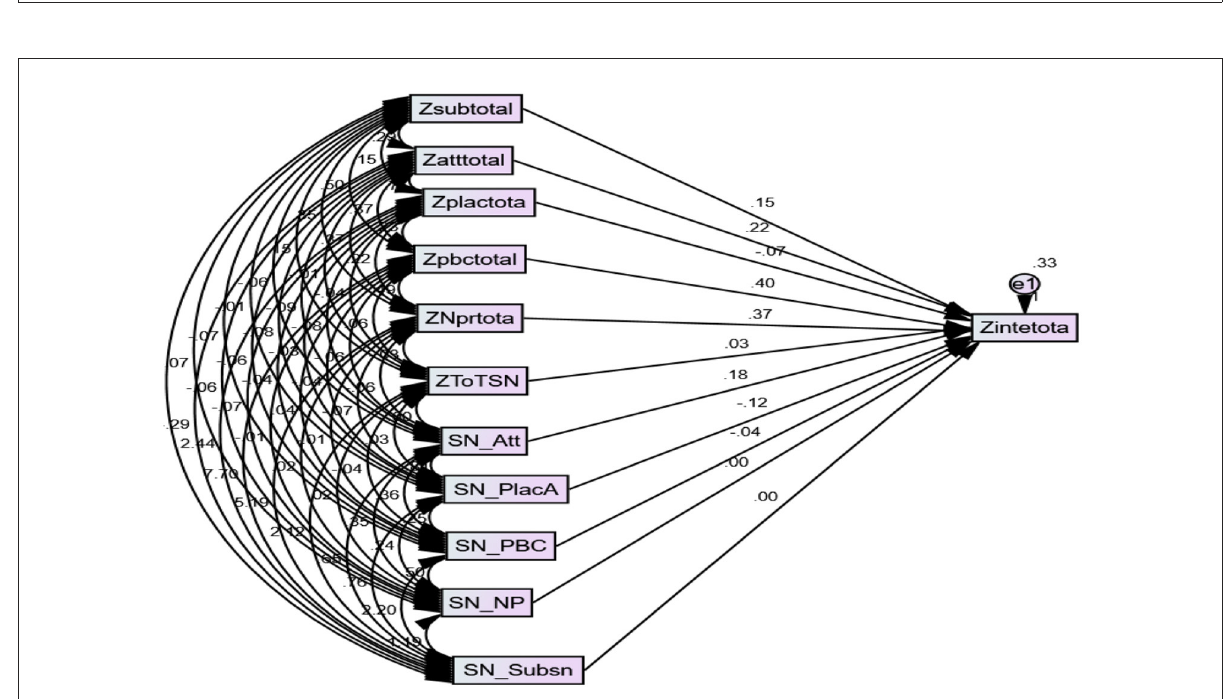
FIGURE2 Path coefficients predicting migration intention from the latent variables and their interaction with the social